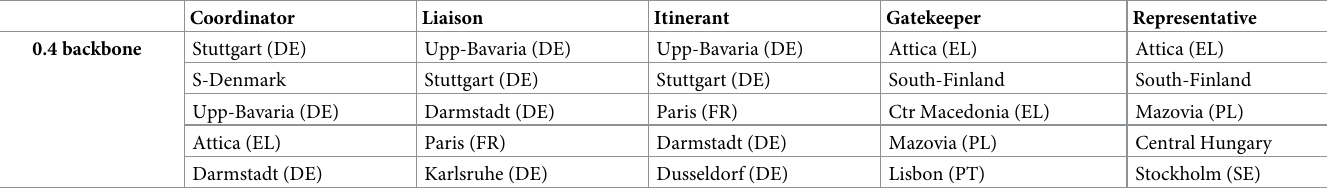
Table 3. Ranking of the top five regions in terms of largest difference between WNGF and